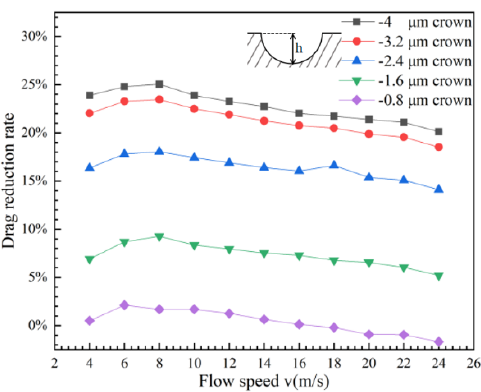
Figure 13. The relationship between the water flow rate and the drag reduction rate of the groove surface of the negative crown with different depths.